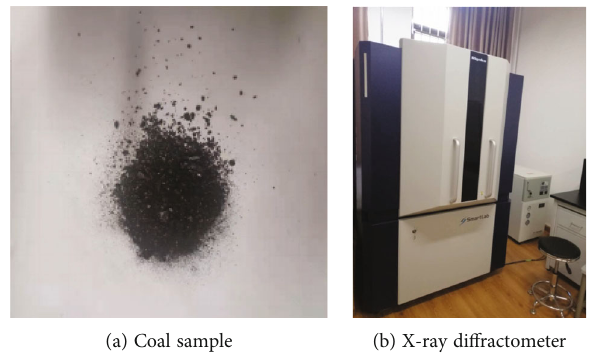
Figure 1: Coal seam mineral component testing.